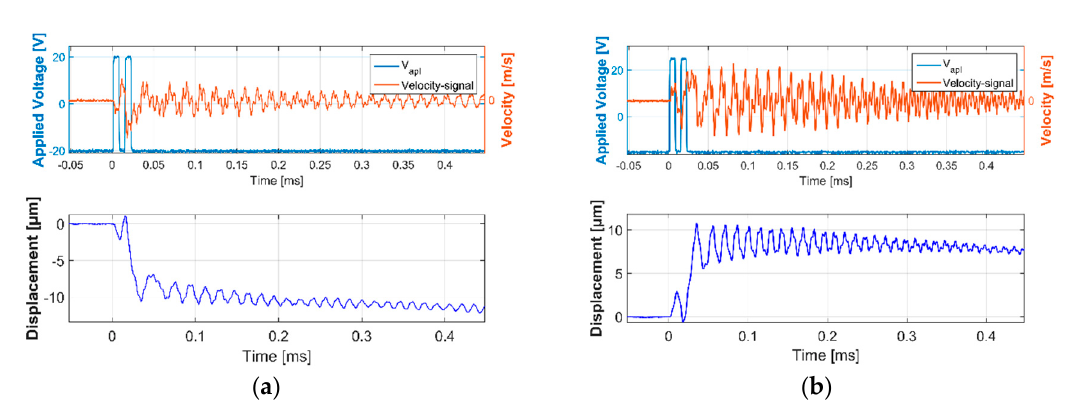
Figure 3. In the top graphs the applied voltage (blue) und the measured velocity (red) are shown and in the bottom the calculated displacement of a 2.9 µm thick membrane with a diameter of 800 µm, whereas ( a ) shows the switching from the top ground state to the bottom ground state (e.g., “switching down”) and ( b ) the switching from the bottom to the top ground state (e.g., “switching